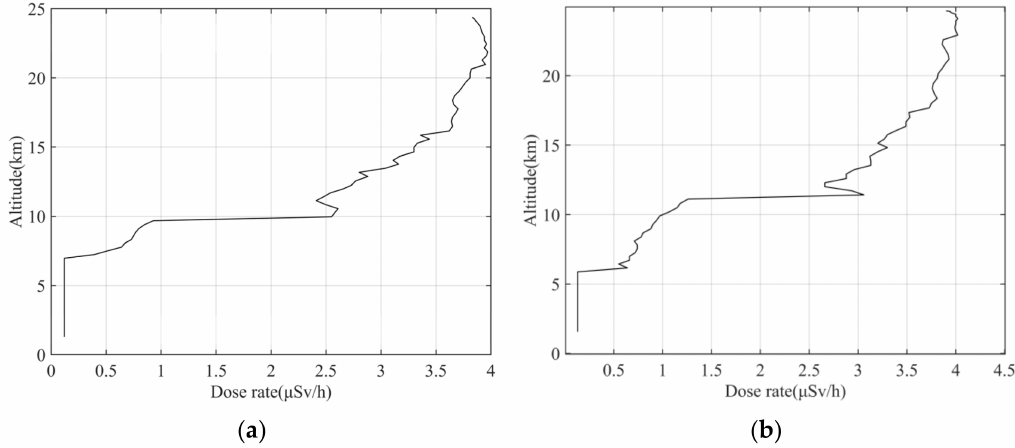
Figure 8. Profiles of the dose rate with altitude on ( a ) Day 1 and ( b ) Day 2, respectively.